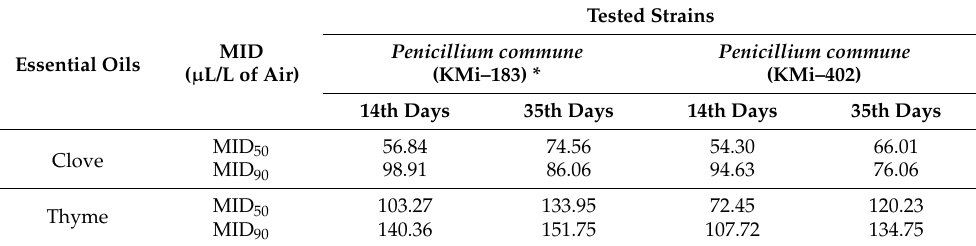
Table 5. Minimum inhibitory doses (MID 50 and MID 90 ) for used essential oils able to inhibit growth of Penicillium commune strains on cheese samples at 5 ± 1 ◦ C (three replications in treatments with each essential oil were screened (four colonies in three repetition ( n = 12)) after 14 and 35 days of